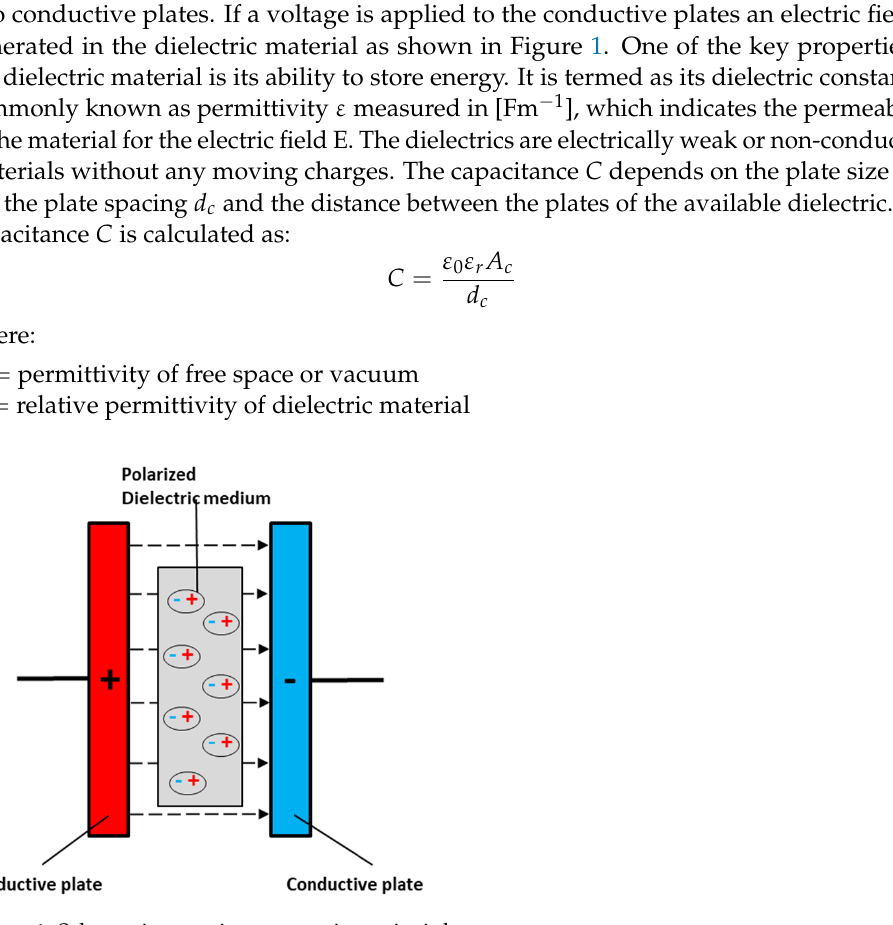
Figure 1. Schematic capacitor measuring principle.